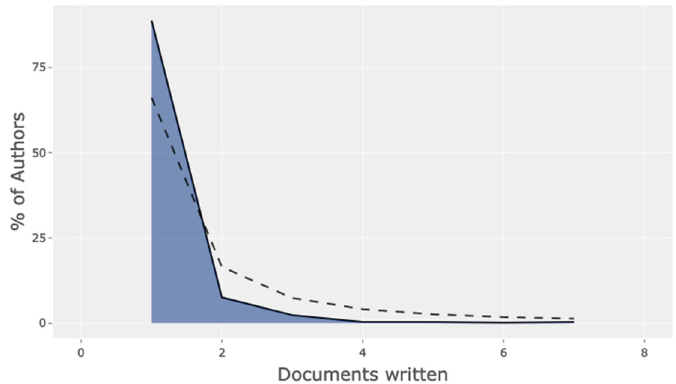
Figure 7. Frequency distribution of authors’ production.